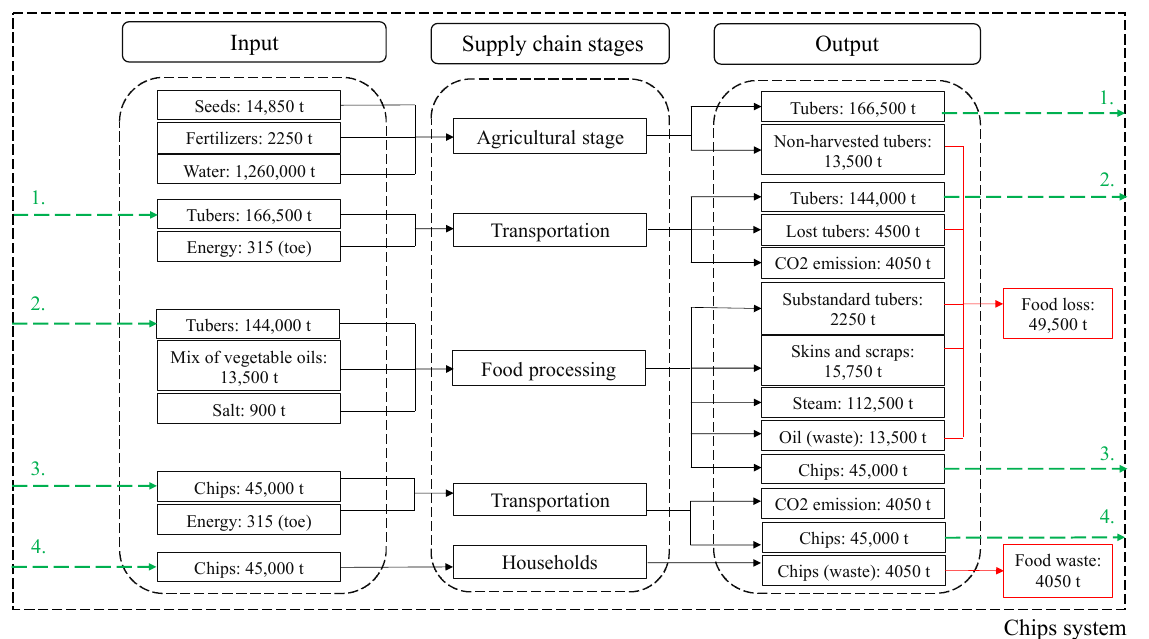
Figure 2. Material flow analysis for the Italian potato chip industry (t). Notes: Number 1 links tubers from the agricultural stage to tubers at the transportation stage. Number 2 links tubers from the transportation stage to tubers at the food processing stage. Number 3 links chips from the food processing stage to chips at the transportation stage. Number 4 links chips from the transportation stage to chips at the household consumption stage. Source: Personal elaboration by the authors.